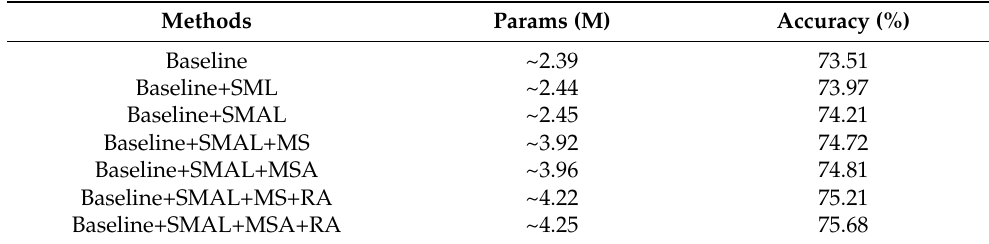
Table 2. The comparison results of ablation experiments on the CAER-S